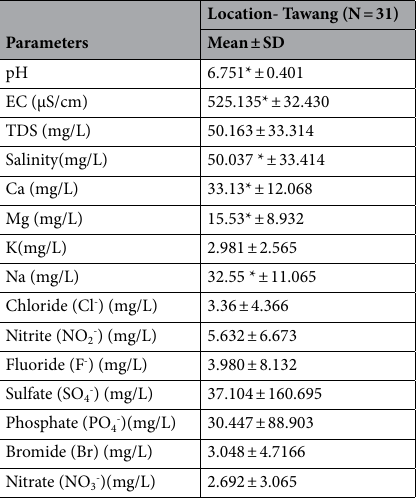
Table 2. Statistical summary of the physio-chemical parameters in the study area. *Means are statistically significant ( p < 0.05).